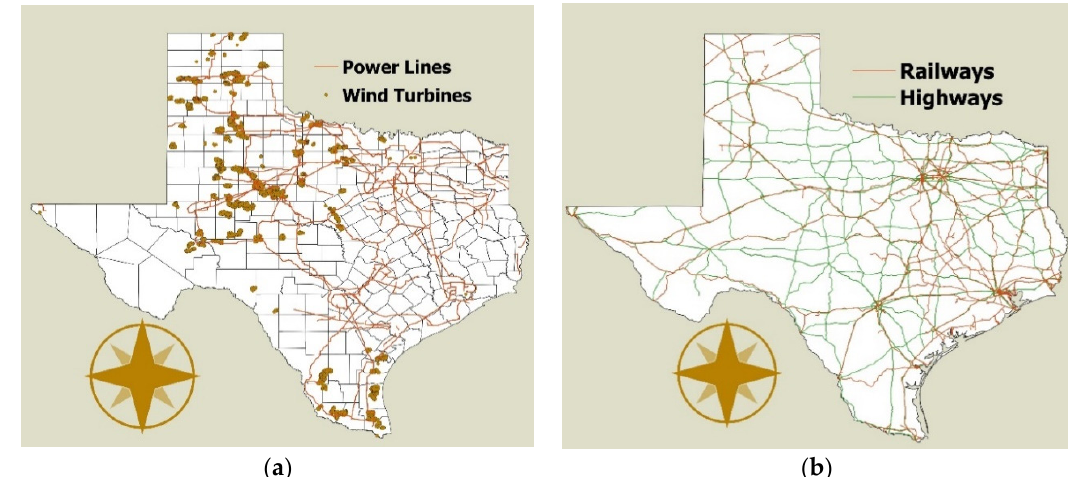
Figure 3. ( a ) Wind turbines in Texas database with power lines. ( b ) Highways and railways database.